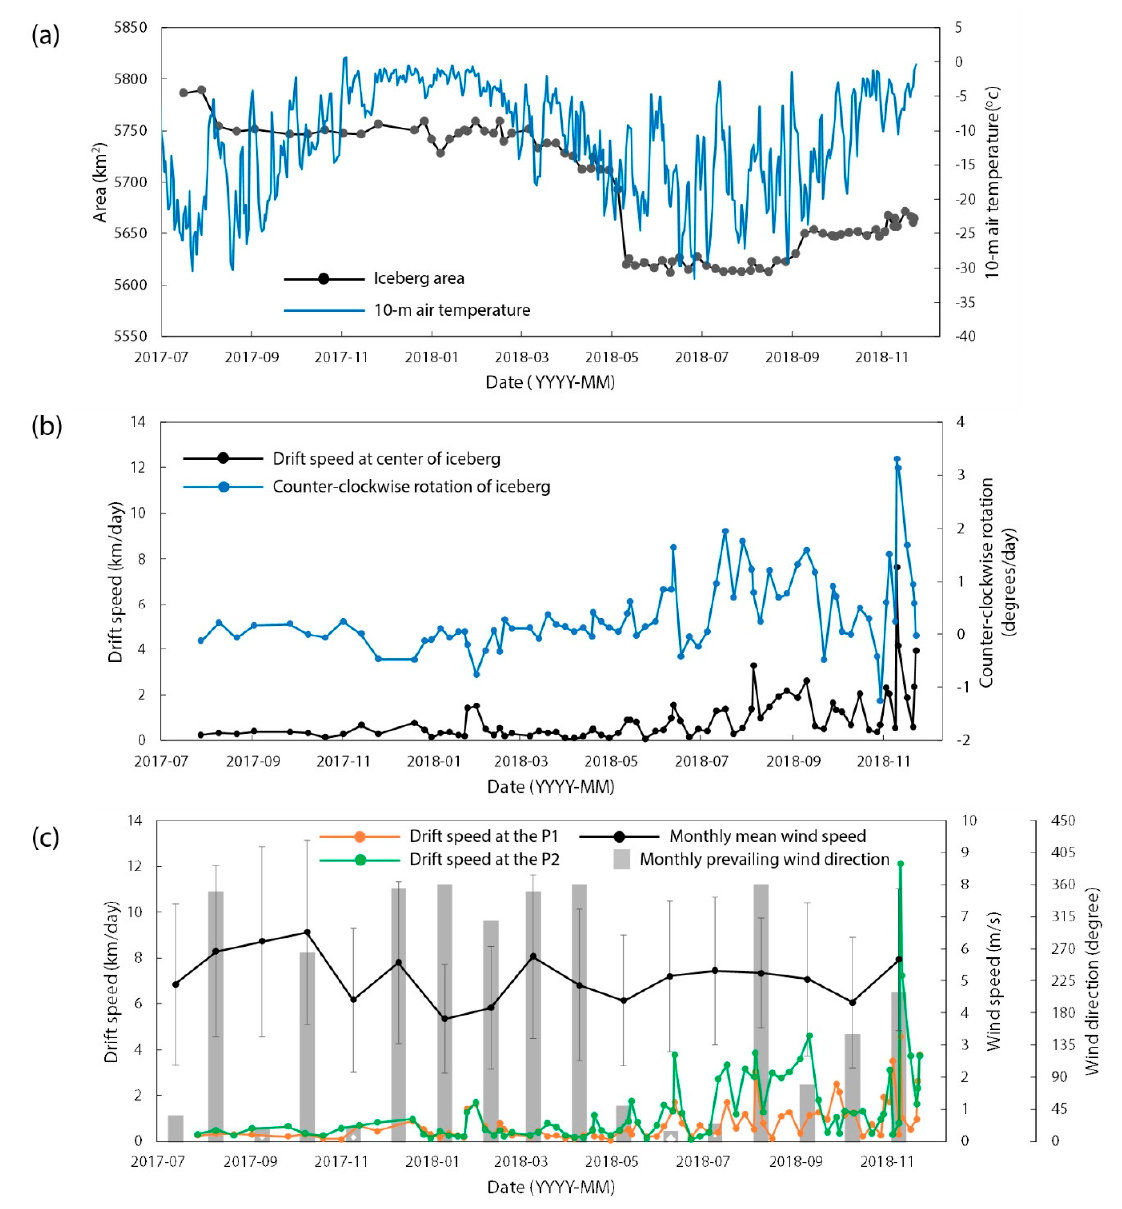
Figure 3. ( a ) Changes in the area of iceberg A68A and 10-m air temperature around the iceberg predicted by the Modern-Era Retrospective analysis for Research and Applications, version 2 (MERRA-2); ( b ) Changes in the drift speed at the center of iceberg A68A and its rotation angle; ( c ) Changes in the drift speed at the location of P1 and P2 of iceberg A68A, and monthly mean wind speed and prevailing wind direction (0 ◦ = from south, 90 ◦ = from west, 180 ◦ = from north, 270 ◦ = from east) around the iceberg predicted by the MERRA-2. The vertical error bars in ( c ) represent the standard deviation of wind speeds for each month.